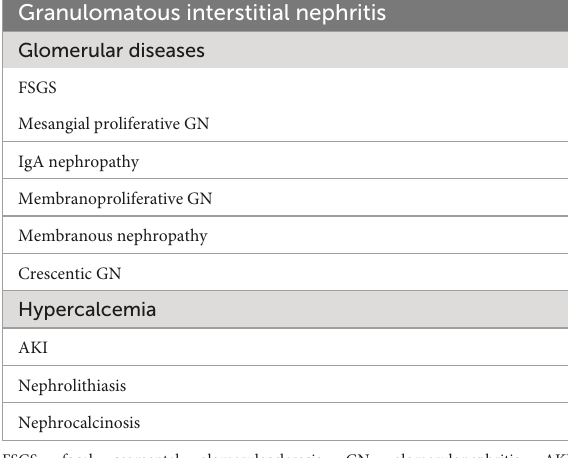
FSGS, focal segmental glomerulosclerosis; GN, glomerulonephritis; AKI,